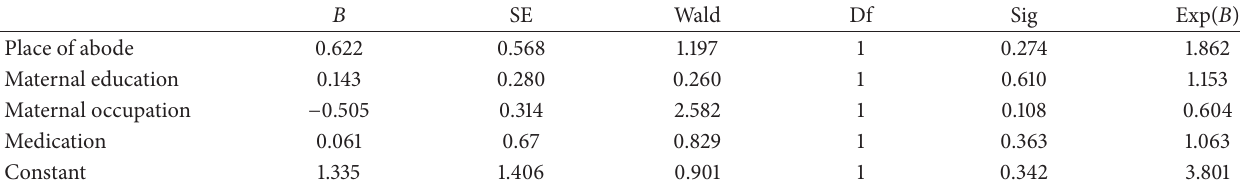
Table 3: Logistic regression of variables that were significantly associated with default from clinics.